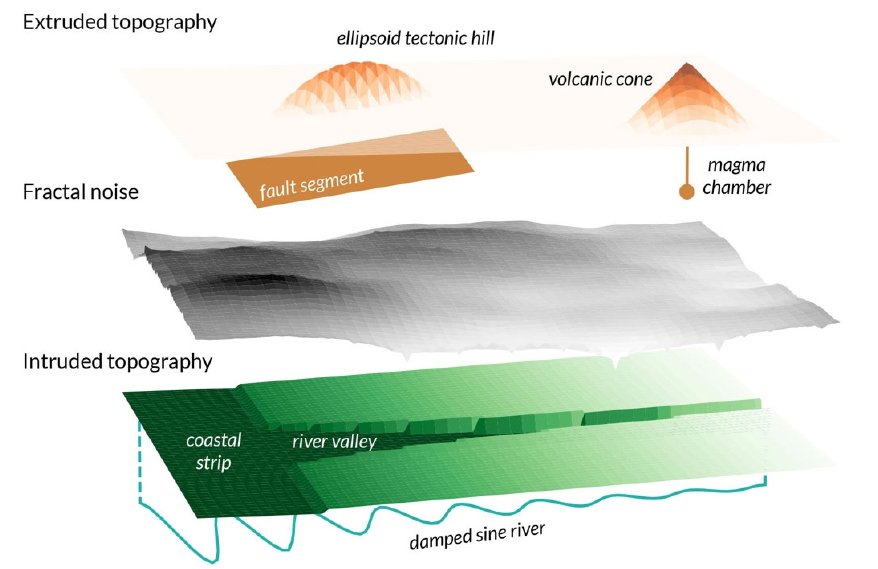
Figure 2. Generation and modification of an environmental layer (here the topography) by intruding and extruding various environmental objects. These objects, which may be associated to